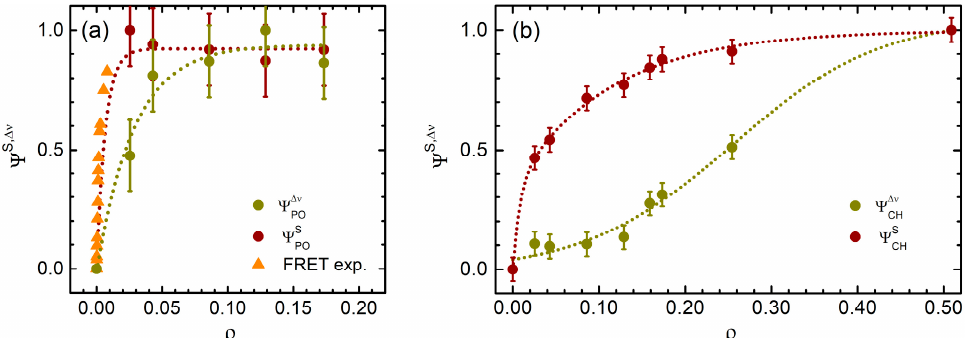
Figure 6. ( a ) Order parameter obtained from the frequency shift Δν (dark yellow) and from the intensities S 2 (dark red) for the phosphate modes, compared to the normalized FRET data, as a function of ρ ; ( b ) order parameter obtained from the frequency shift Δν (dark yellow) and from the intensities S 2 (dark red) for the hydrocarbon modes as a function of ρ . Fits to data are reported as dotted lines as guides to eyes.